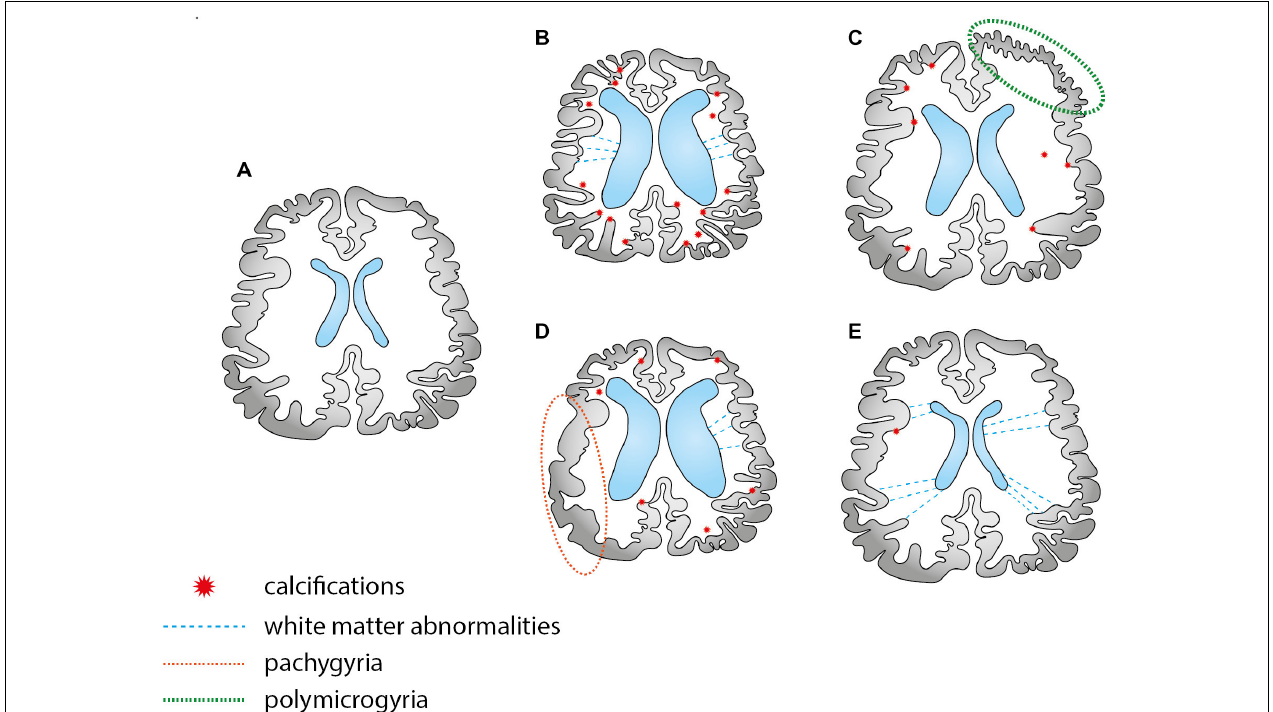
FIGURE 4 | A few schematic examples of possible combinations of brain abnormalities in the CZS. There are two types of abnormalities: those that can be easily identified by the traditional imaging scans, such as calcifications and ventriculomegaly in CT scans; subtle alterations that are difficult to trace, requiring specific MRI sequences (frequently investigated in the scope of research). Scheme (A,B) depicts two typical images, normal developing and microcephalic brain, respectively. Schemes (C,D) depicts migration cortical abnormalities, such as pachygyria and polymicrogyria, better investigated by specific structural MRI sequences. Case (E) depicts a normocephalic case with subtle abnormalities in the white matter, better investigated by diffusion MRI techniques.